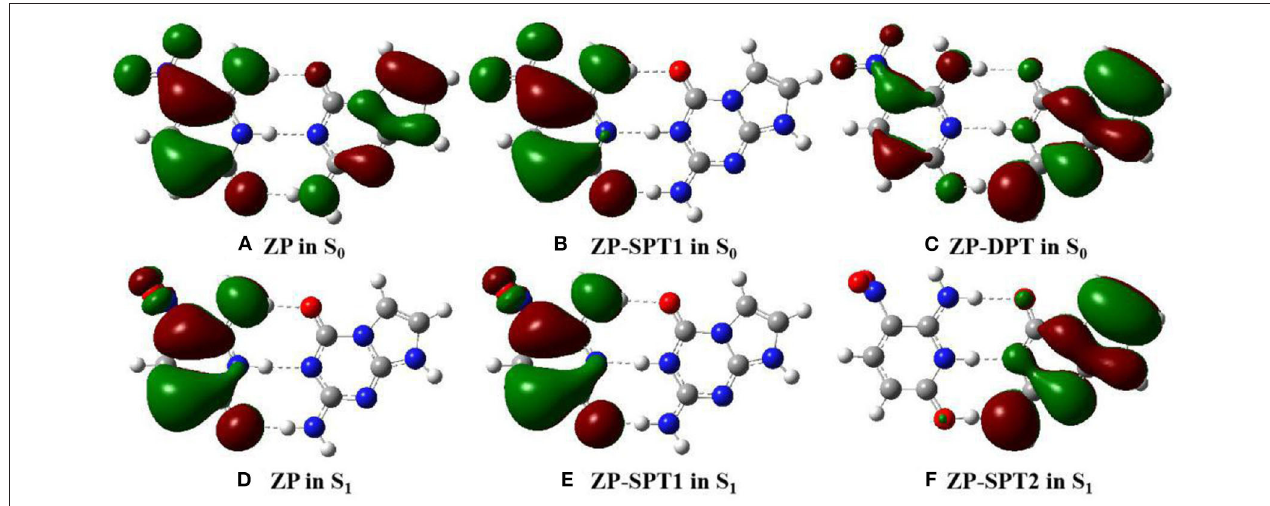
FIGURE 3 | View of HOMO for the normal ZP and tautomers in solution at B3LYP-D3(BJ)/6-311 ++ G(d,p)/IEFPCM level. The green opaque shade and red opaque shade are for positive and negative parts of the wave function (isovalue = 0.02), respectively. (A) ZP in S 0 . (B) ZP-SPT1 in S 0 . (C) ZP-DPT in S 0 . (D) ZP in S 1 . (E) ZP-SPT1 in S 1 . (F) ZP-SPT2 in S 1